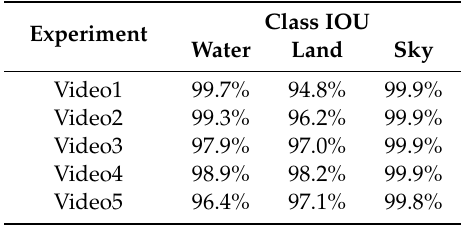
Table 1. Intersection over Union (IoU) results in each